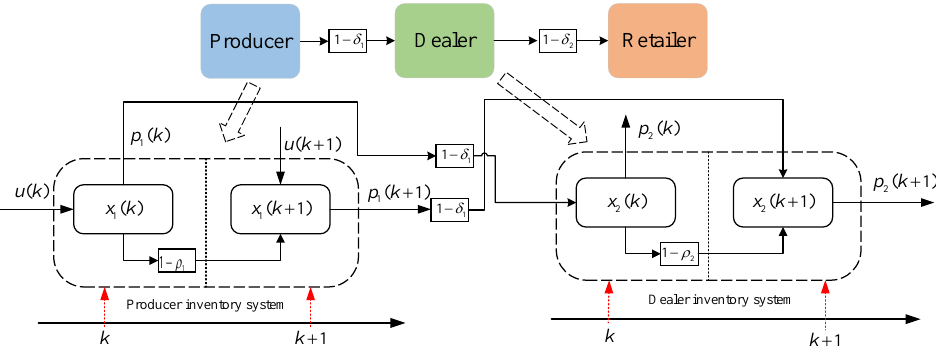
Figure 3. Diagram of the operation of the three-level supply chain inventory